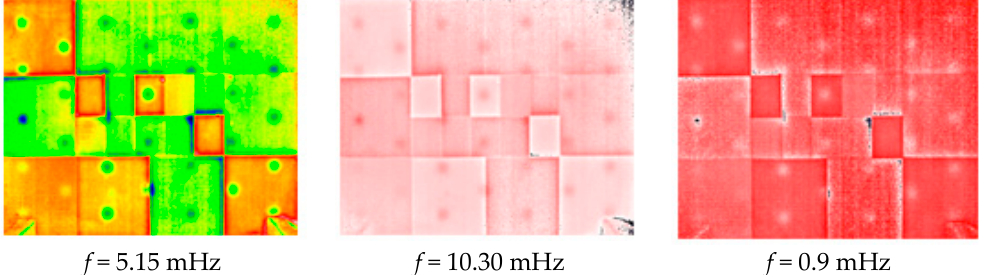
Figure 16. Phase images of the calculated harmonic response.